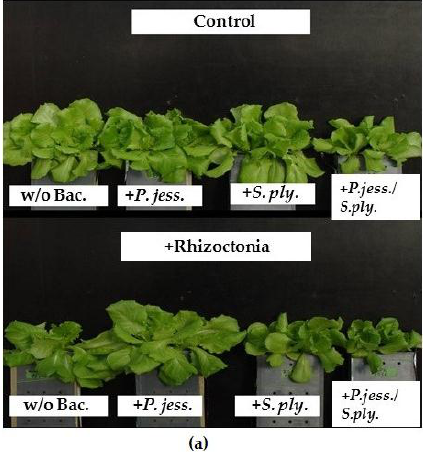
Table 1. Shoot dry mass (g plant −1 ) of Lactuca sativa L. cv. Tizian grown on three different soils without (control) and with inoculation of Rhizoctonia solani AG1-IB (+ Rhizoctonia ). (++ Plants died within the first week after Rhizoctonia solani